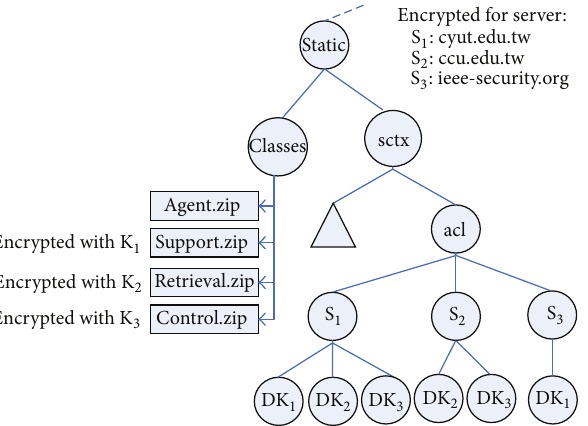
Figure 1: Tree-based structure of key management and access control.